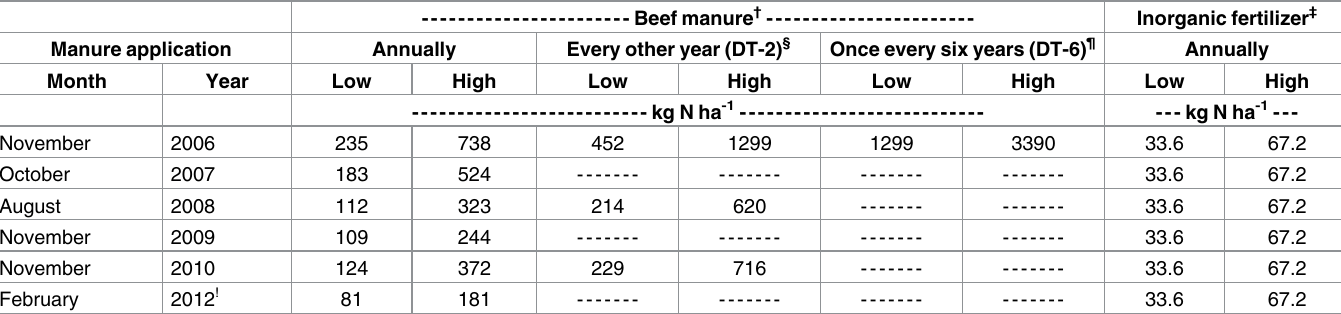
Table 3. The amount of manure and chemical fertilizer application (kg N ha -1 ) since the initiation of the study from 2006 to 2013 growing seasons. Manure